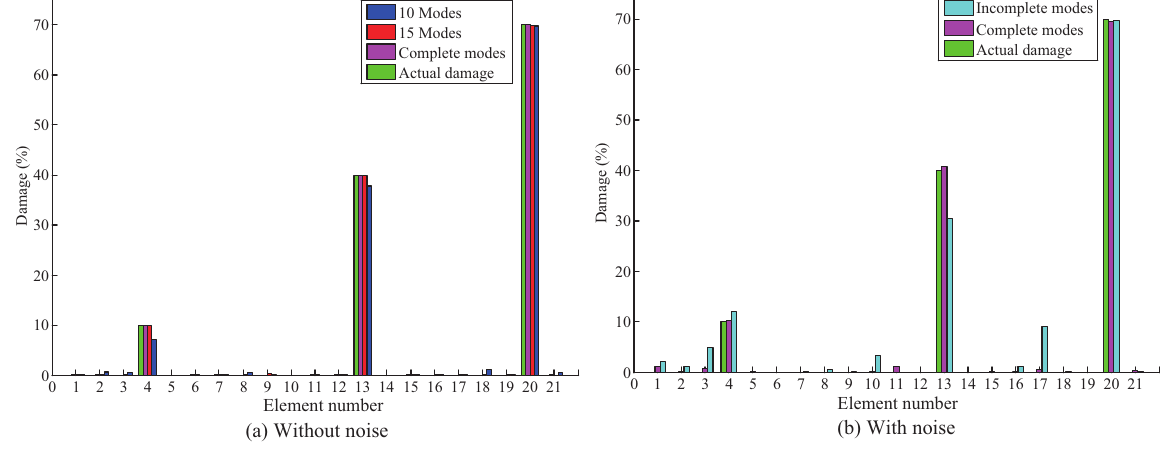
Fig. 9. Damage distribution of Belgian truss using the complete and incomplete modal data in Scenario 3.